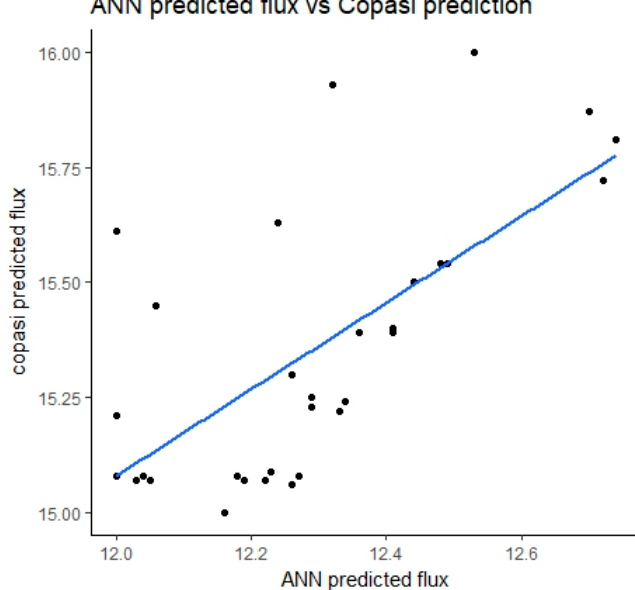
Figure 10. Comparison between glass ceiling ANN (GC-ANN) predicted flux and simulated flux. The enzyme balance corresponding to these flux values are selected for experimental validation of the methodology .